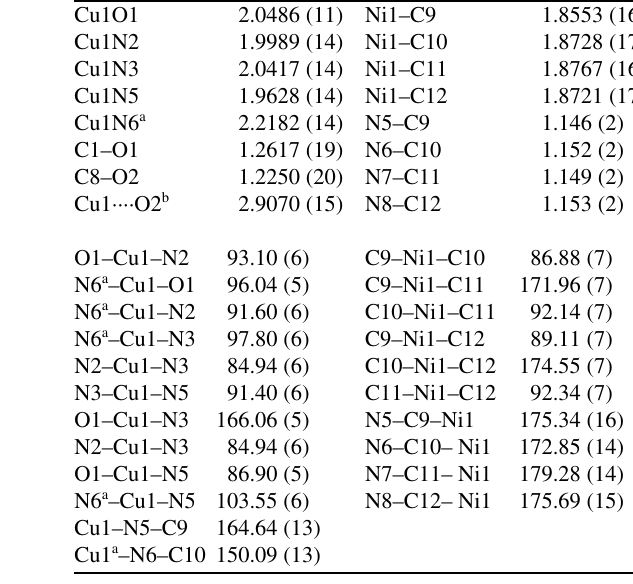
Table 2. Selected bond lengths (Å) and angles (°) in [ Cu(bcen) Ni(CN